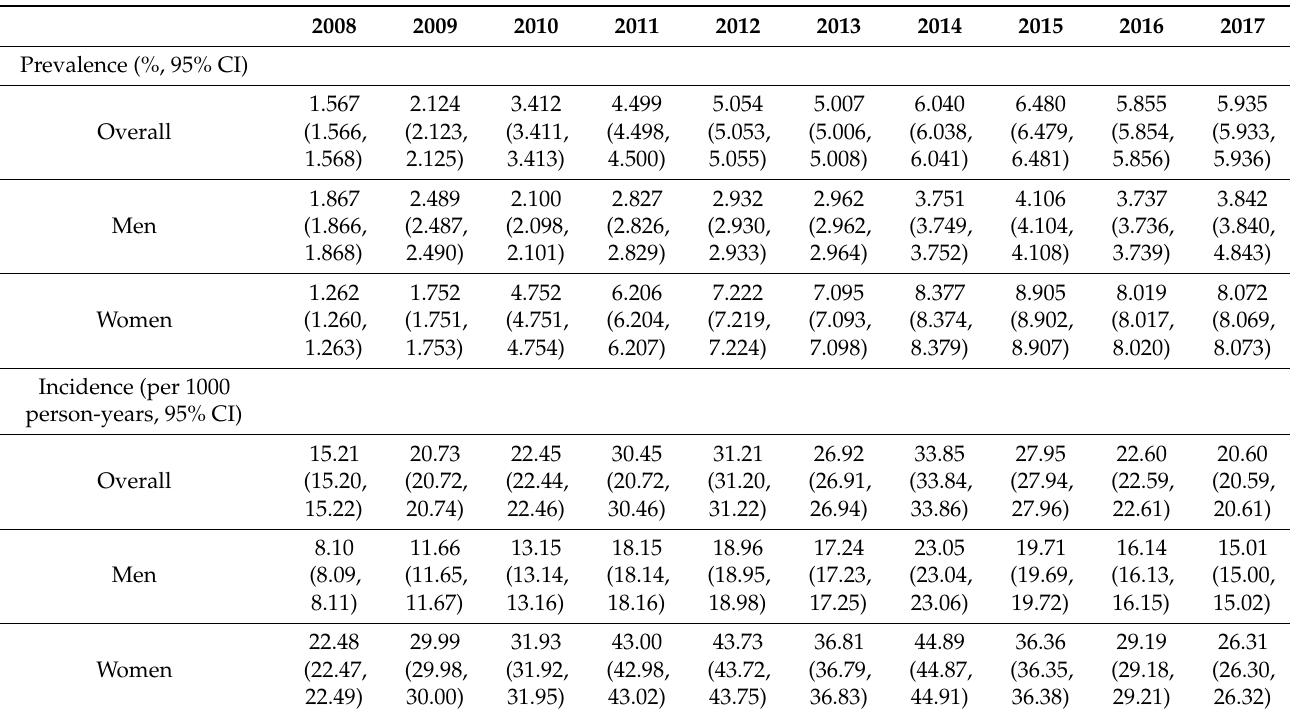
Table 2. Age-standardized prevalence and incidence of diagnosed knee osteoarthritis in Beijing, China,